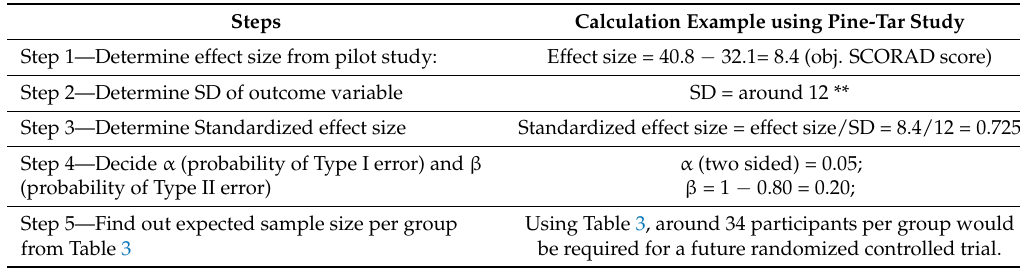
Table 4. Summary of steps for sample size